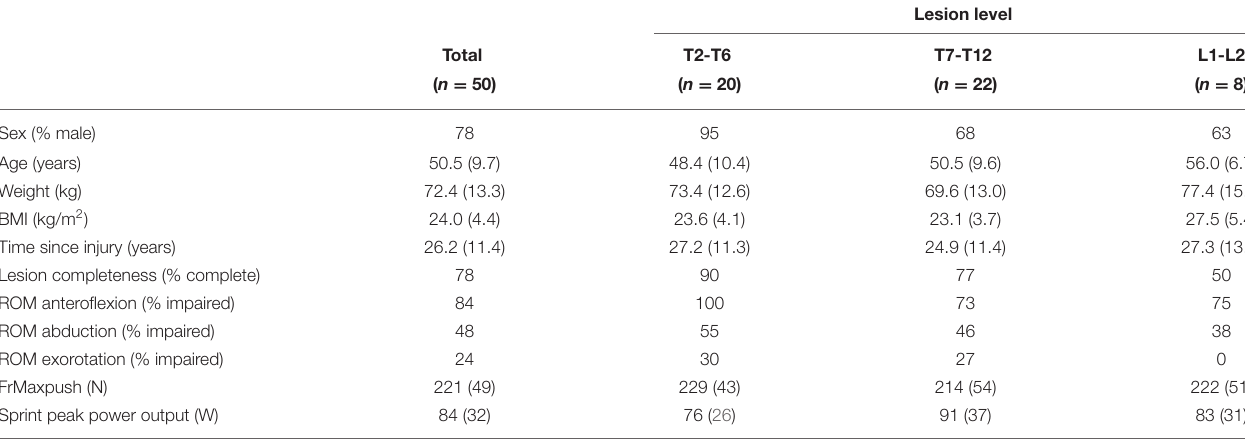
TABLE 1 | Subject characteristics, lesion characteristics, and wheelchair user capacity [% or mean (SD)] for the total sample and stratified by lesion level.